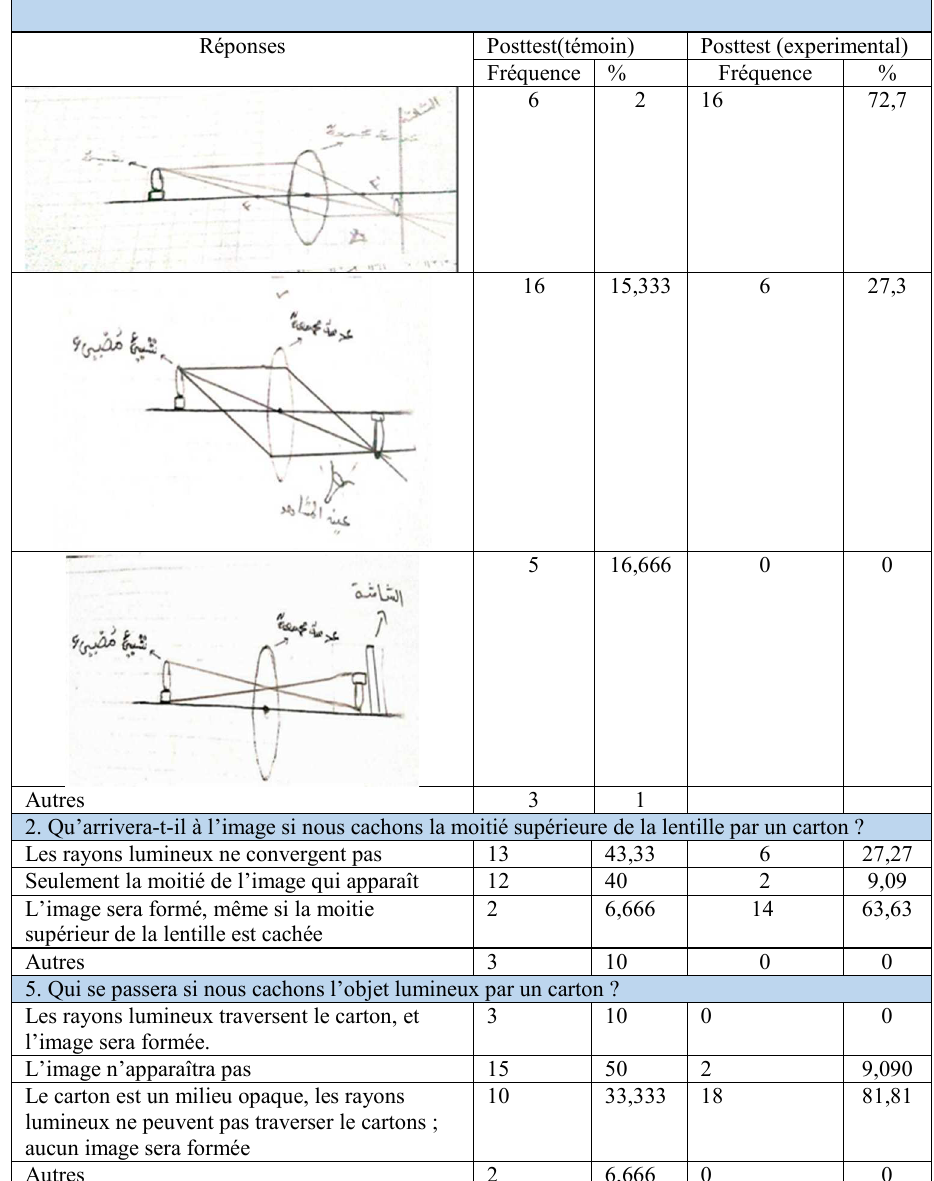
Tableau 2. Les conceptions des élèves qui ont été trouvées. Après l’apprentissage. 1. Comment l’image se forme à travers une lentille convergente